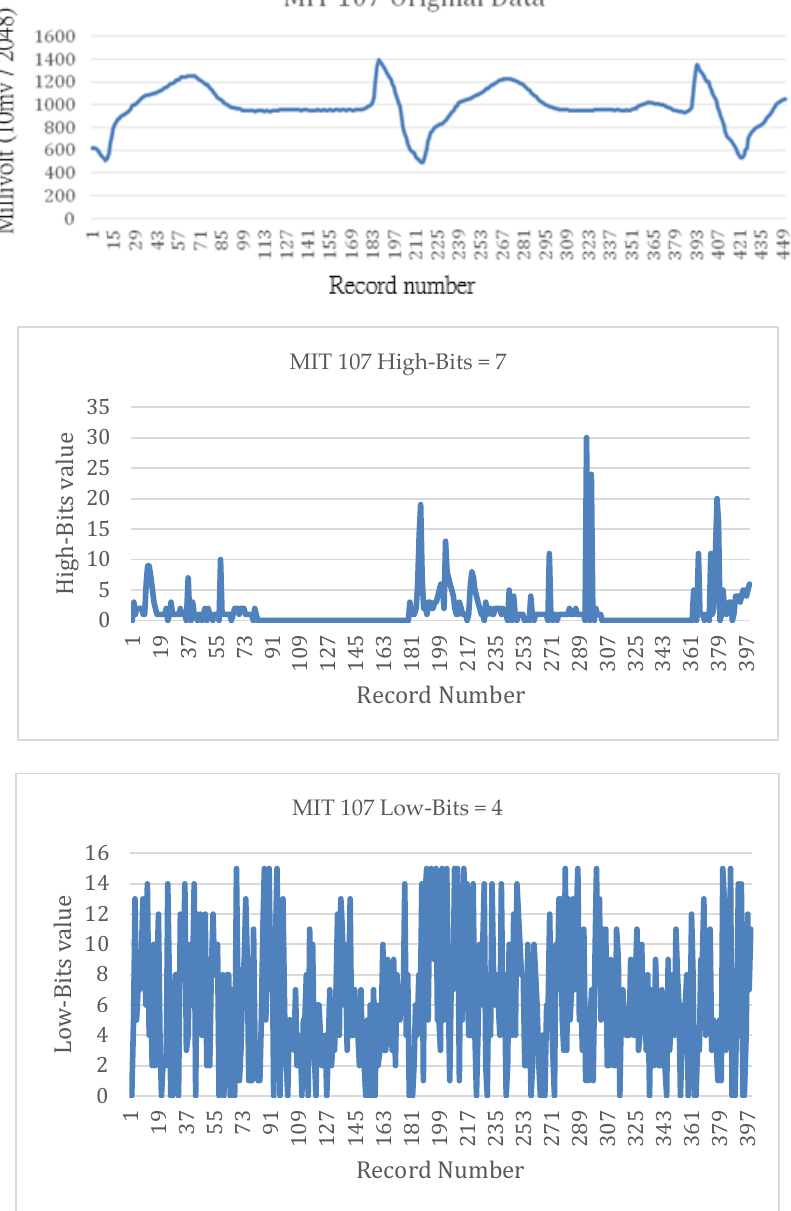
Figure 10. Worst case: MIT/BIH Arrhythmia Database recording 107 high bits = 10.